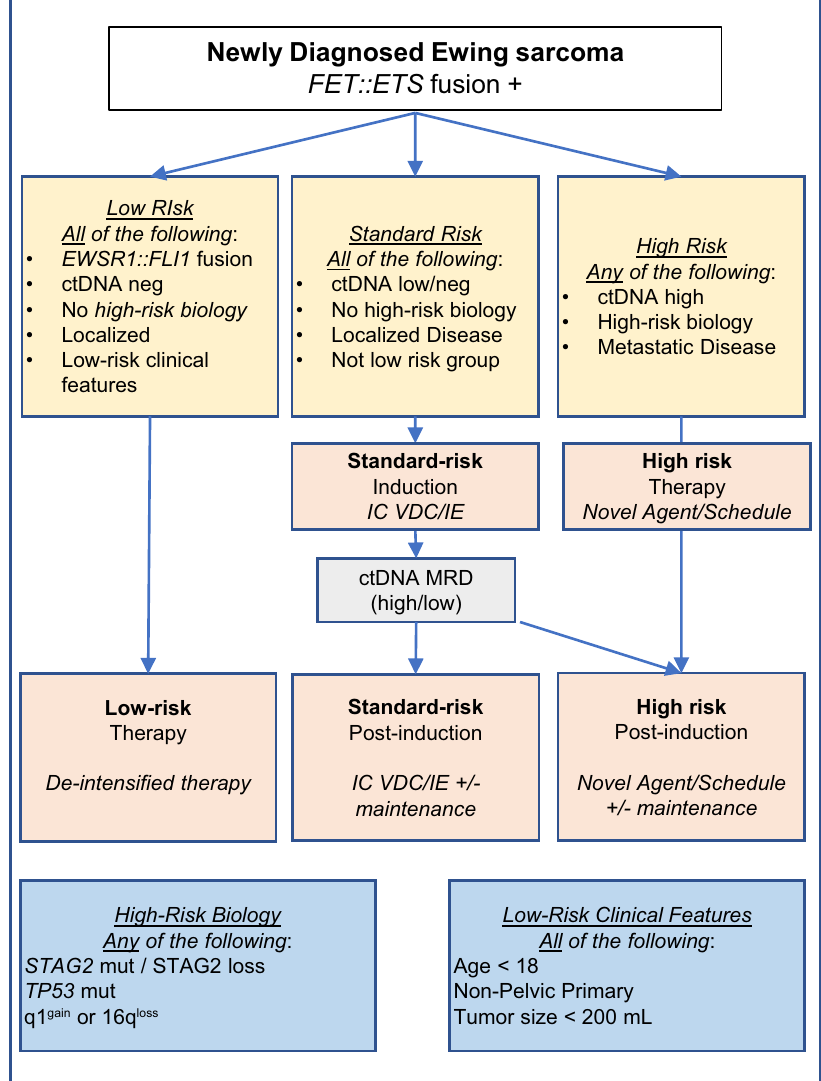
Fig. 4 Hypothetical risk-strati fi ed treatment schema. We provide a hypothetical risk-strati fi cation schema that one could envision as the biomarkers described in this manuscript are validated. This schema incorporates clinical and molecular